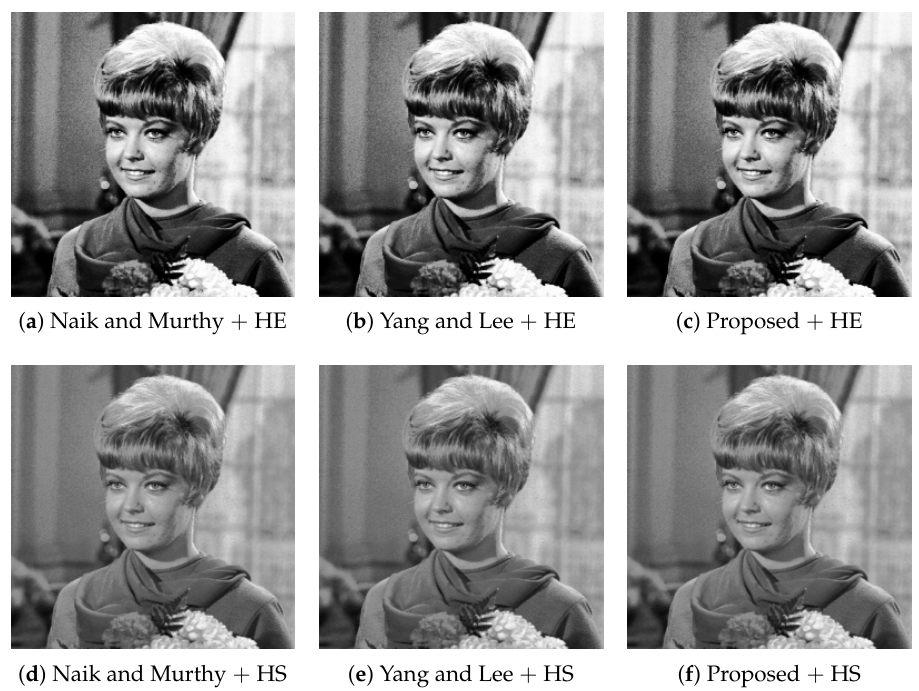
Figure 8. Luminance images computed from the corresponding color images in Figure 6: the top row ( a – c ) shows the luminance images with histogram equalization (HE) for computing target intensities, and the bottom row ( d – f ) shows that with histogram specification